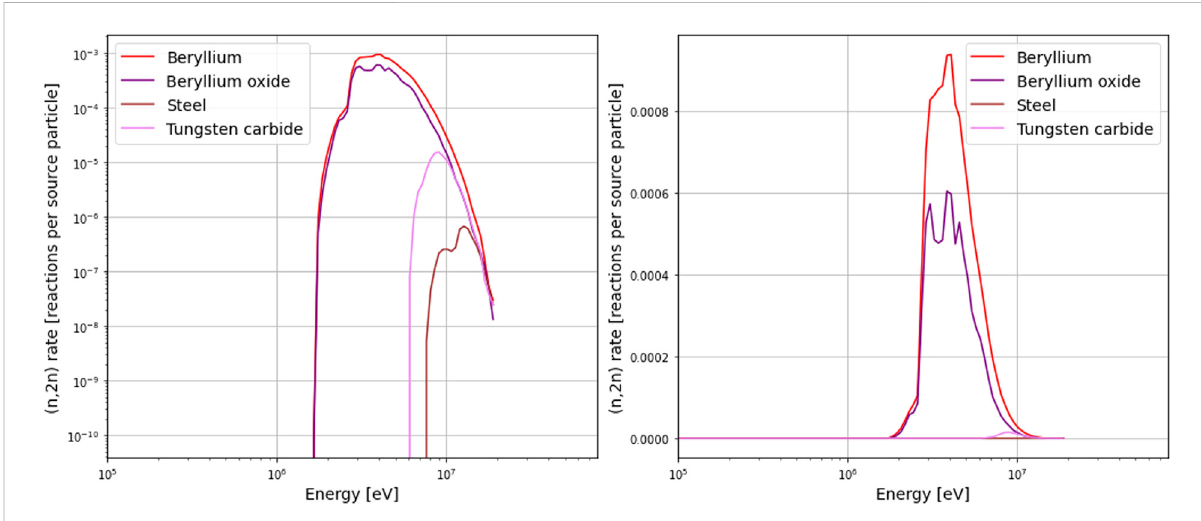
FIGURE 7 The (n, 2n) reaction rate distributions versus incident neutron energy.